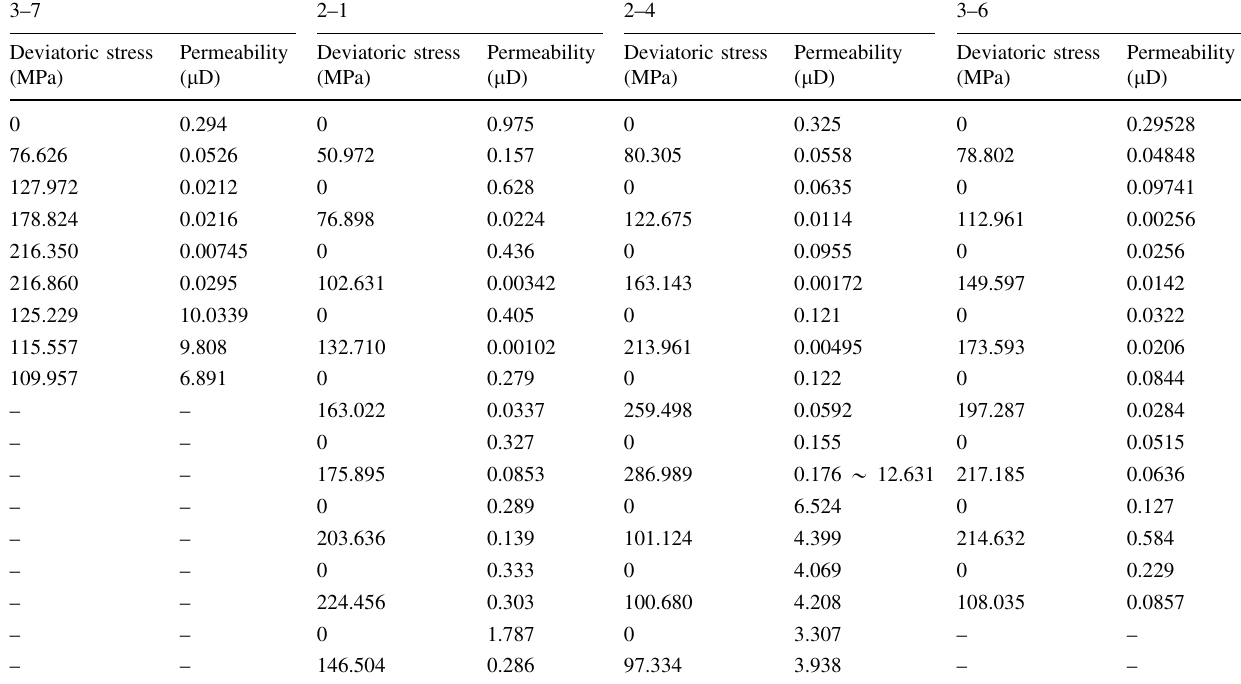
Table 2 Permeability measurement